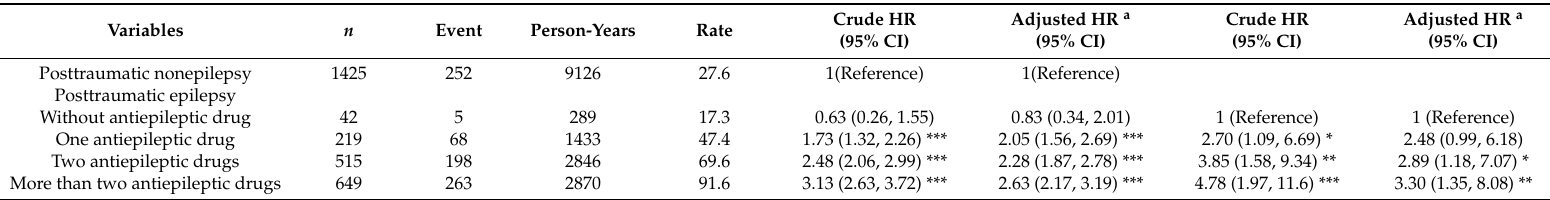
Table 4. Incidence and hazard ratio of mortality compared among PTE patients with different number of AED (anti-epileptic drug) use and compared to PTN. Variables n Event Person-Years Rate Posttraumatic nonepilepsy 1425 252 1(Reference) 1(Reference) Posttraumatic epilepsy Without antiepileptic